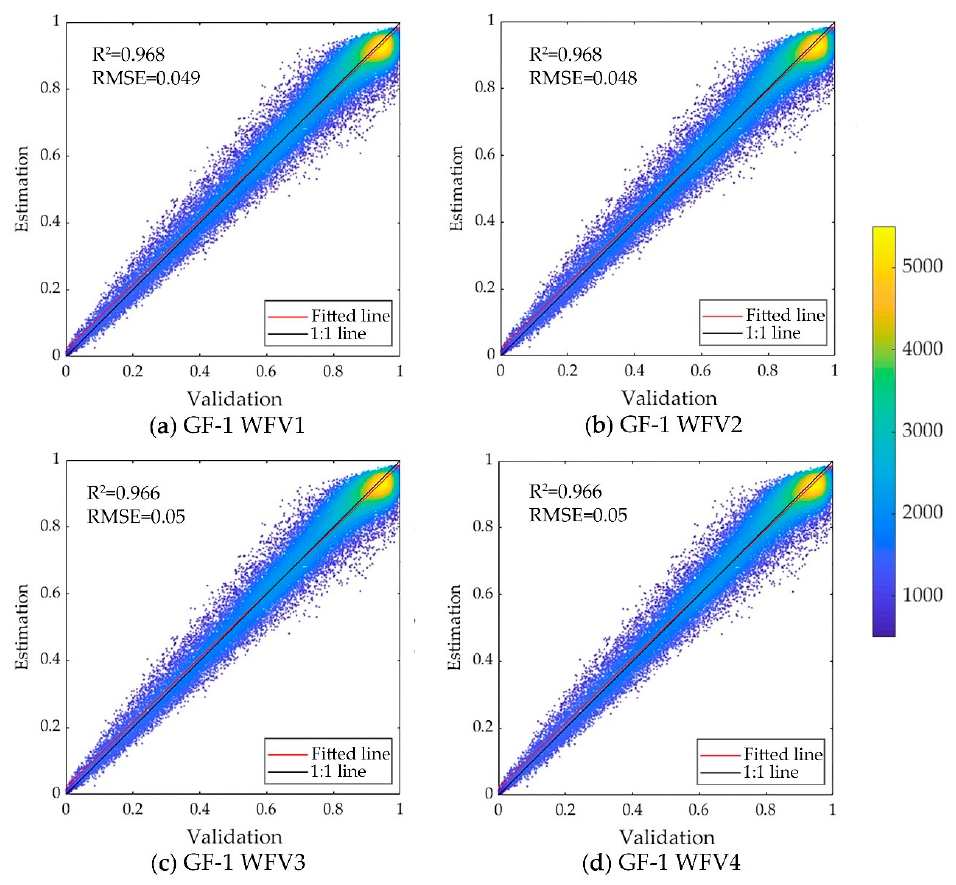
Figure 5. Validation based on the simulated data for GF-1 WFV 1 ( a ), GF-1 WFV 2 ( b ), GF-1 WFV 3 ( c ) and GF-1 WFV 4 ( d ).